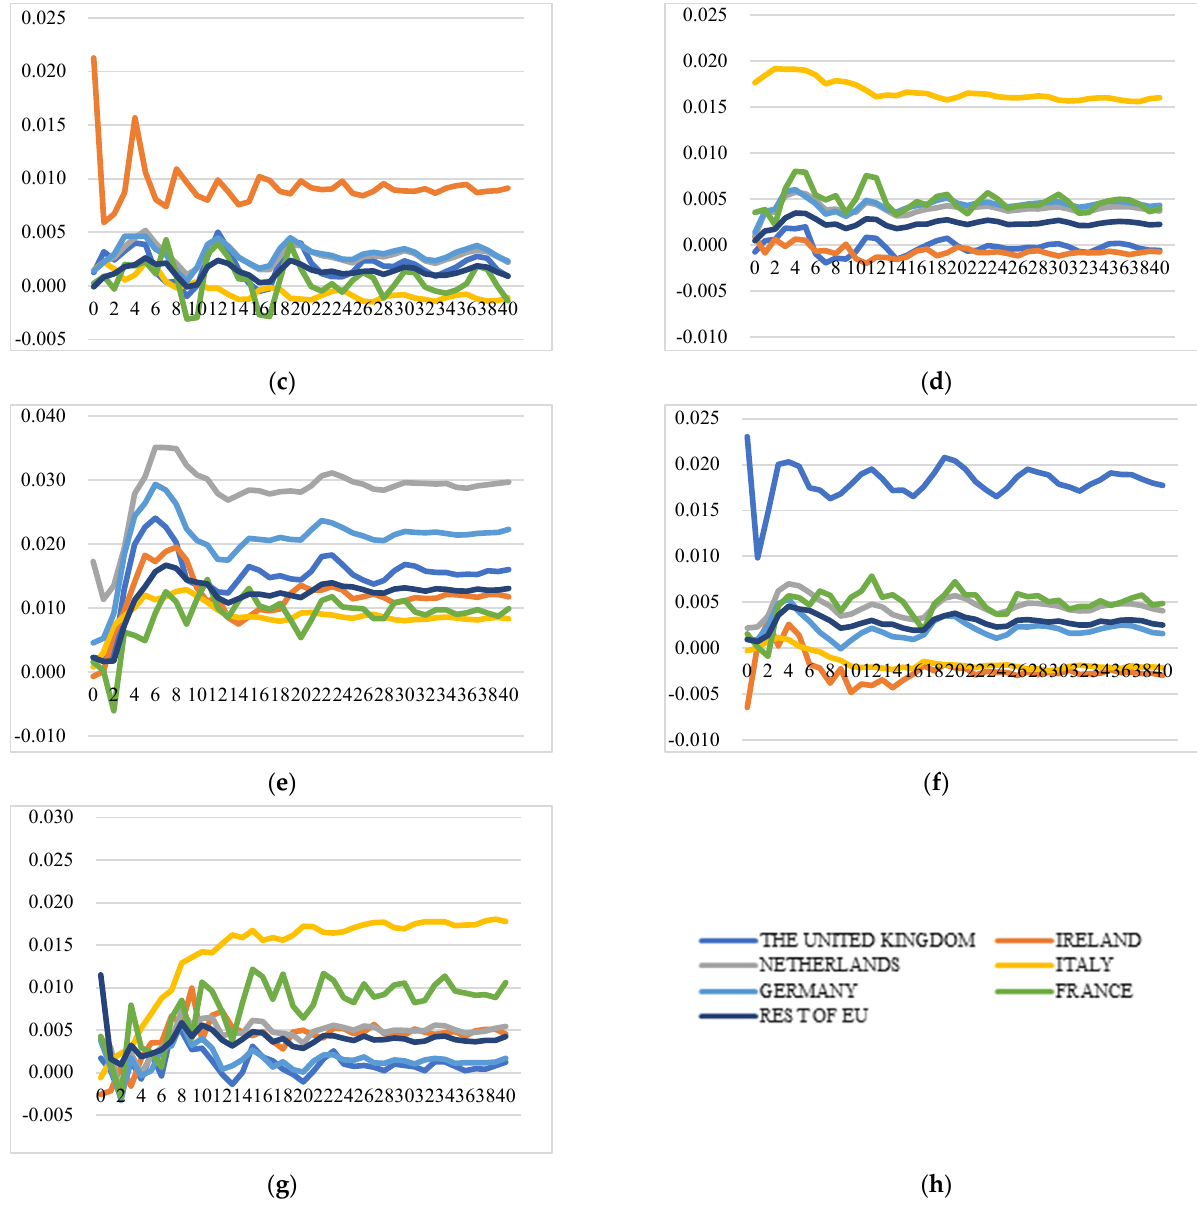
Figure 5. Generalized impulse response functions (GIRFs) of six EU member states’ intra-EU cheese export prices after a positive one-standard-error shock to intra-EU cheese export price (bootstrap median estimates). ( a ) GIRFs after a shock to France’s intra-EU export price. ( b ) GIRFs after a shock to Germany’s intra-EU export price. ( c ) GIRFs after a shock to Ireland’s intra-EU export price. ( d ) GIRFs after a shock to Italy’s intra-EU export price. ( e ) GIRFs after a shock to the Netherlands’ intra-EU export price. ( f ) GIRFs after a shock to the UK’s intra-EU export price. ( g ) GIRFs after a shock to the rest of the EU’s intra-EU export price. ( h ) legend.